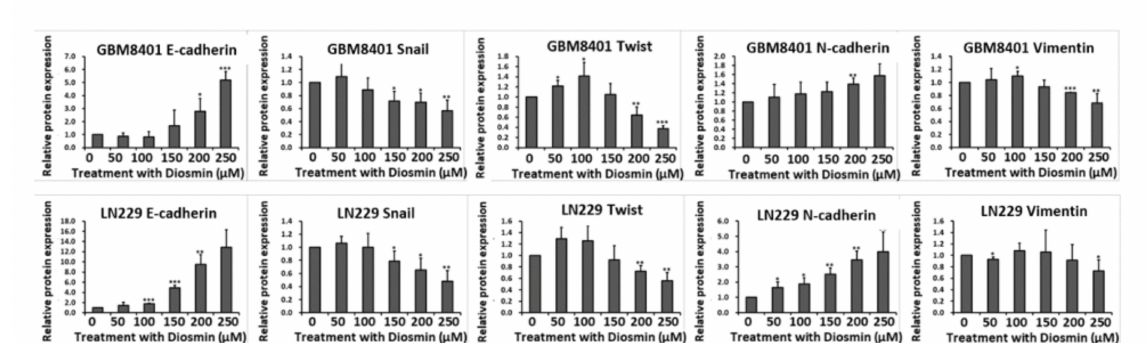
Figure 4. Diosmin reduces the migratory and invasive activities of GBM cells. ( A ) LN229 and GBM8401 cell monolayers in 6 well plates were scratched and then incubated for 16 h with or without the indicated concentrations of diosmin. Wound areas were quantitatively analyzed with ImageJ software and expressed relative to hour 0. ( n ≥ 3; * p < 0.05; ** p < 0.01.) ( B ) Invasive activity of LN229 and GBM8401 cells was assessed and quantified with Transwell invasion assays. Invasion areas are presented as the mean ± S.D. ( n ≥ 3; * p < 0.05; ** p <0.01, *** p < 0.001). ( C ) LN229 and GBM8401 cells were incubated for 48 h with the indicated concentrations of diosmin, after which whole-cell lysates were prepared and subjected to western blot analysis of E-cadherin, Snail, Twist, N-cadherin, and Vimentin expression. The quantification of proteins relative to ACTN was shown in the lower panel ( n ≥ 3). * p < 0.05, ** p < 0.01, and *** p < 0.001 vs. control